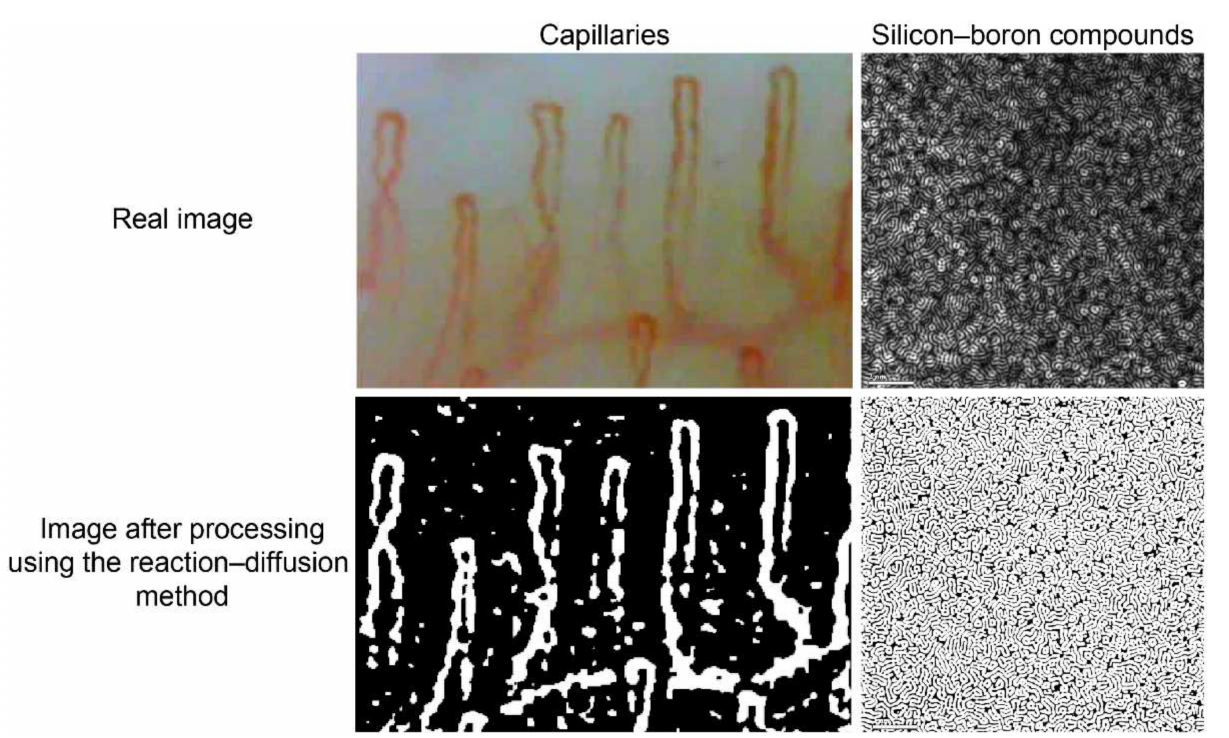
Figure 3. The left panels show the real image of capillaries at the base of the fingernails and the image after processing using the reaction–diffusion method. The right panels show the real image of silicon–boron compounds and the image after processing using the reaction–diffusion